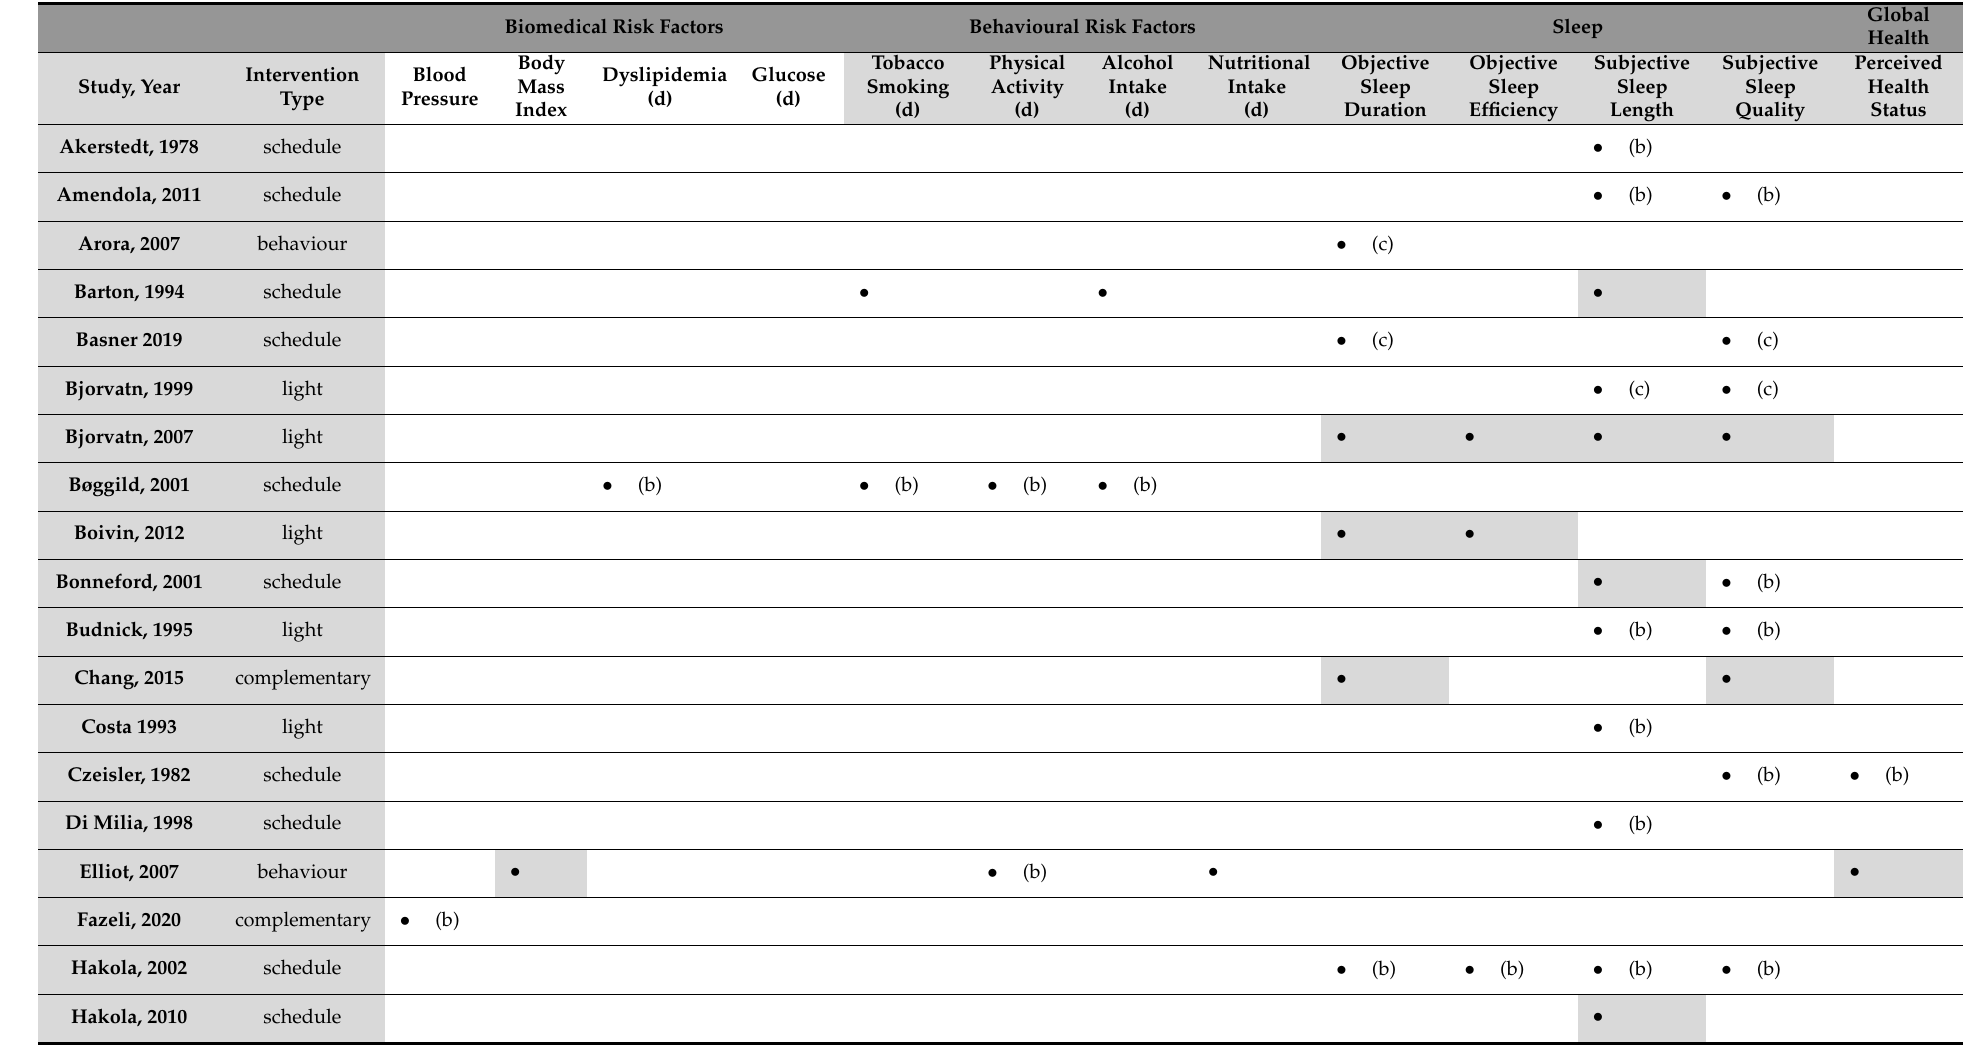
Table 2. Outcomes reported by each study, with shaded boxes indicating inclusion in